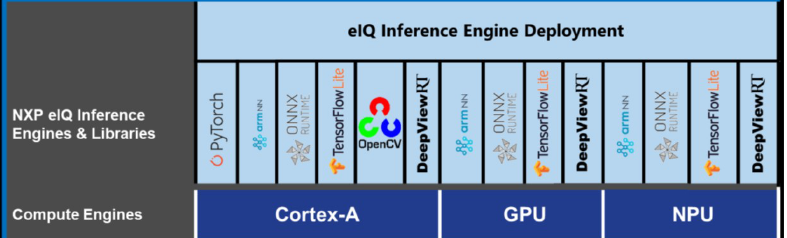
Figure 4. i-MX8 Deep Learning runtime environments supported by embedded computing